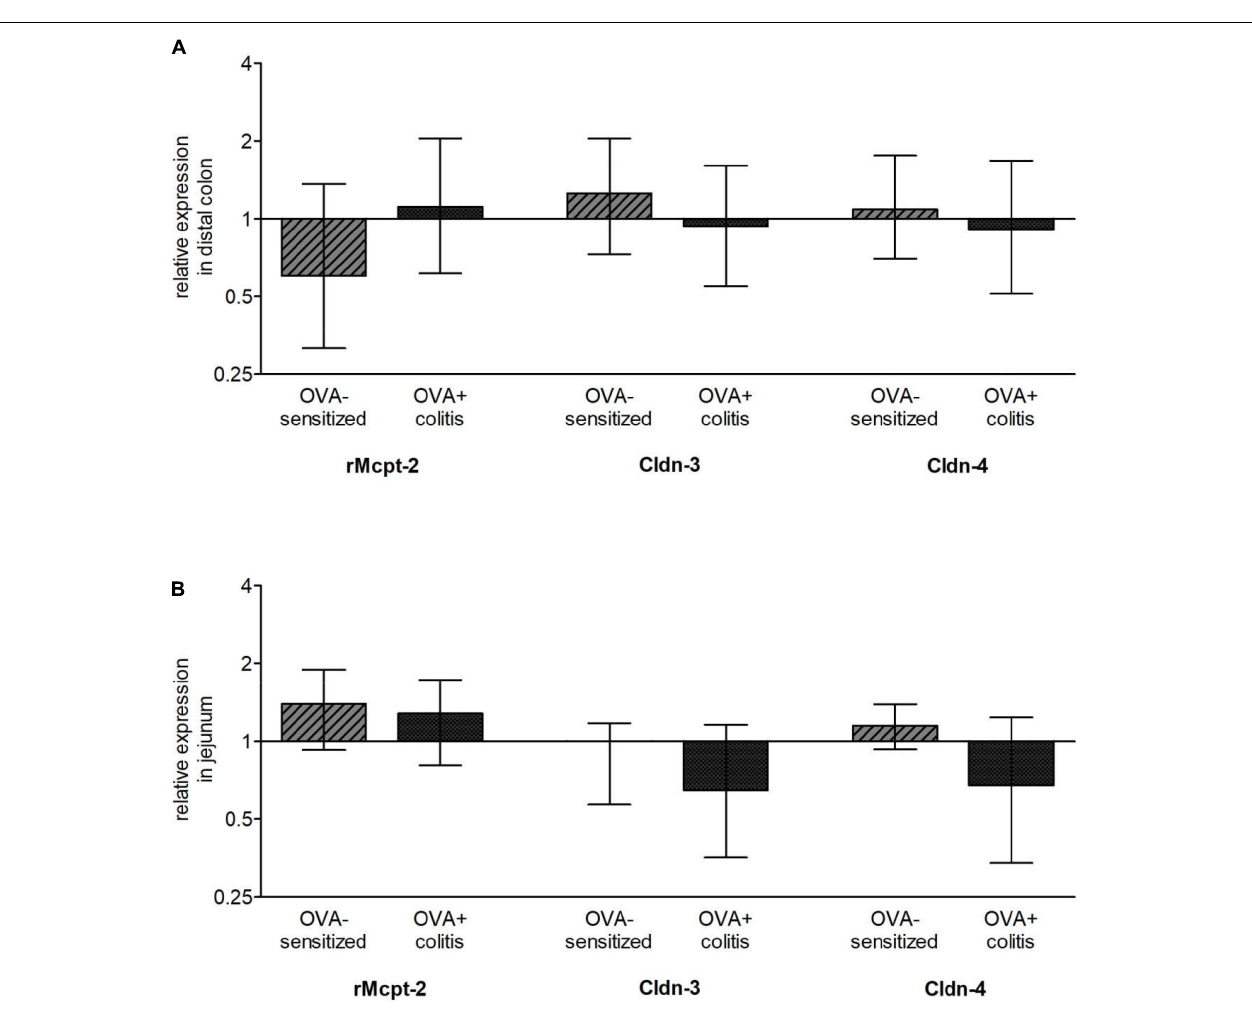
FIGURE 8 | Relative expression of chymase (rMcpt-2), claudin-3 (Cldn-3), and claudin-4 (Cldn-4) in comparison to control animals in distal colon (A) and jejunum (B) . Up- (ratio > 1) and downregulation (ratio < 1) are shown on a log2 scale. As stable expressed reference genes (defined by NormFinder) Gapdh and B2m for the distal colon and Ppia and Rplp2 for the jejunum were used. Data expressed as median (bars) ± SEM (lines), n = 3–6. None of these changes reached statistical significance when tested with REST R (cid:13) (pair wise fixed reallocation randomization test©).